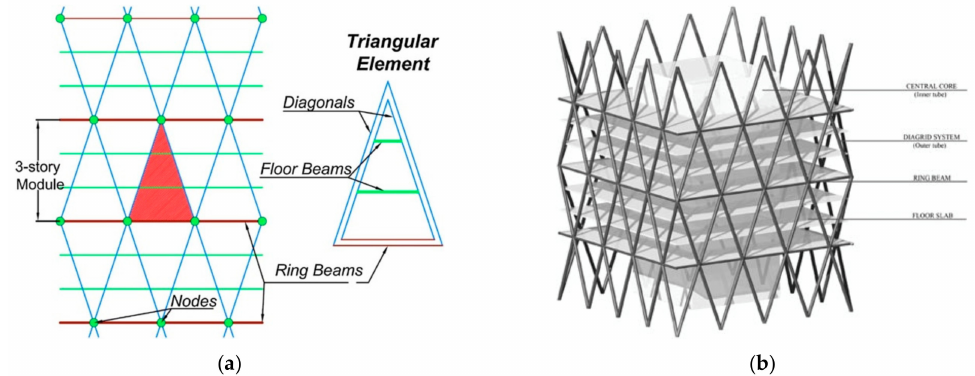
Figure 3. Fundamental diagrid geometrical features: ( a ) diagrid module and basic triangular element, used with permission from Asadi and Adeli [8]; ( b ) diagrid tubular configuration, used with permission from Angelucci and Mollaioli